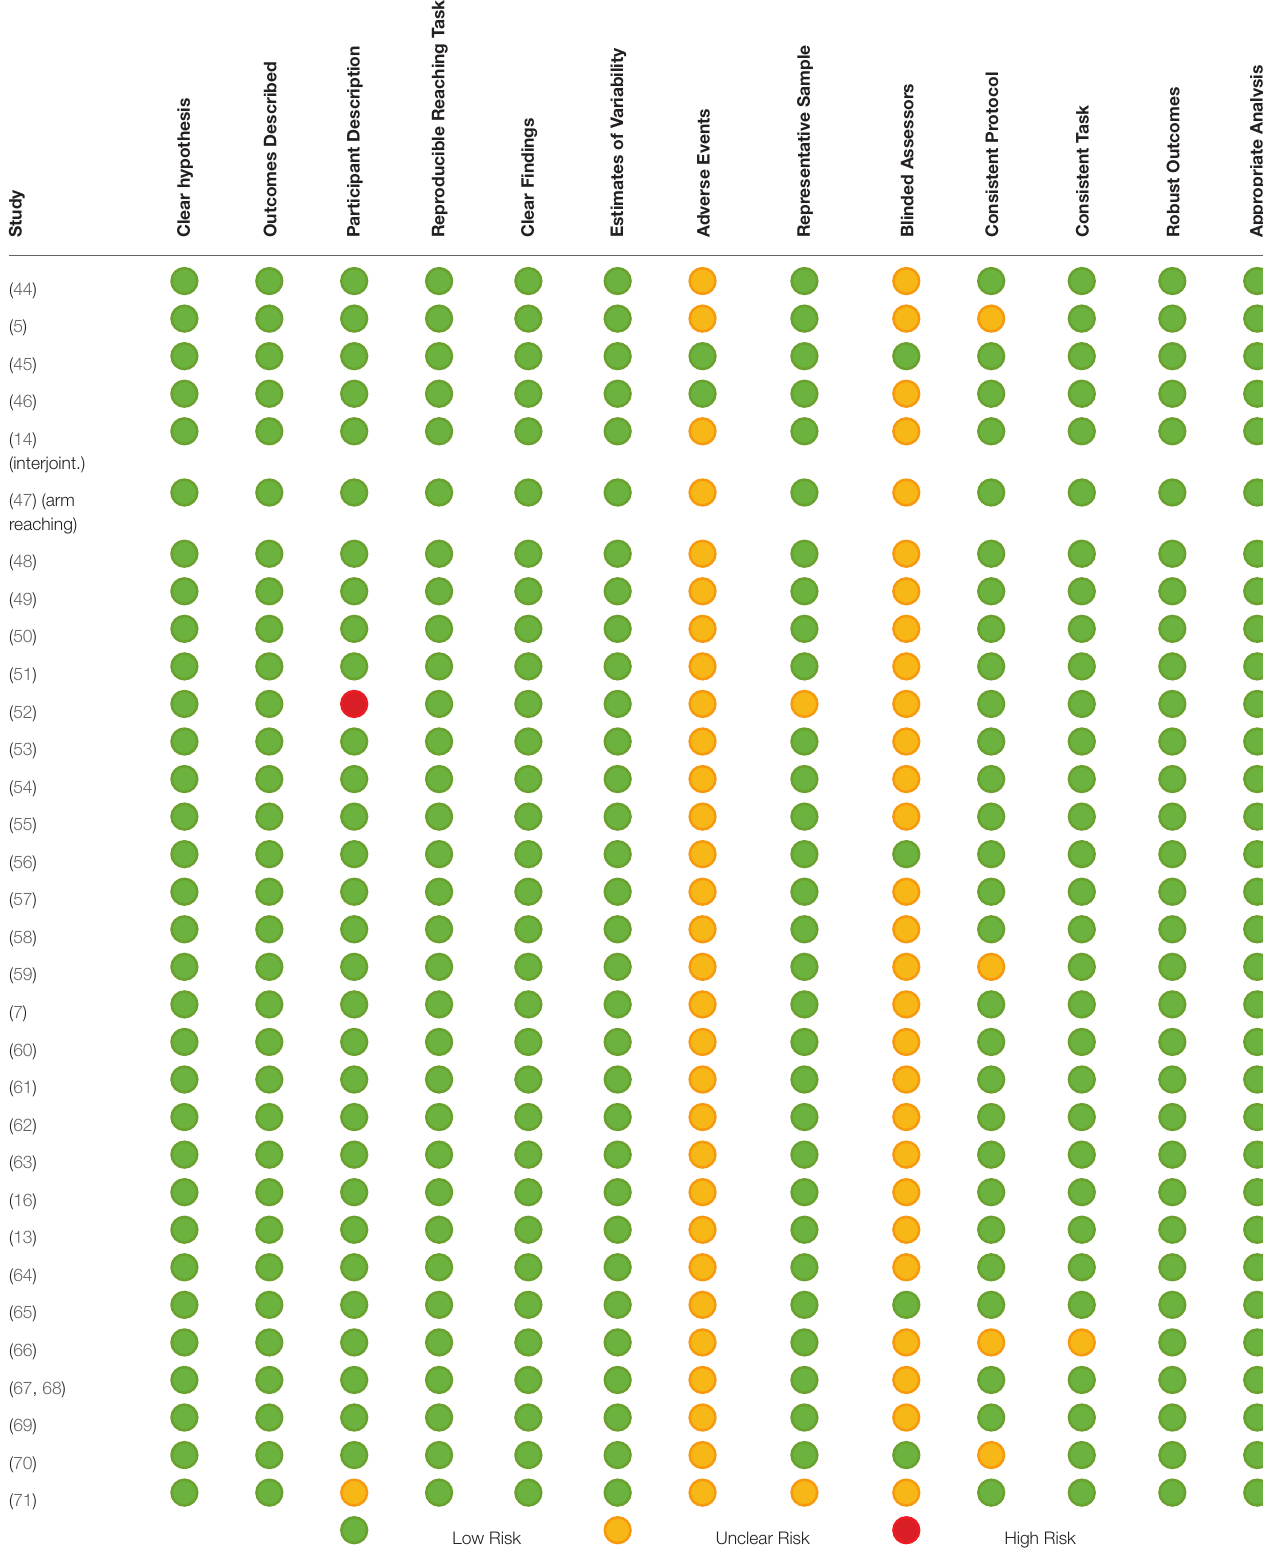
TABLE 6 | Potential risk of bias of included studies assessed using the modified Down’s and Black